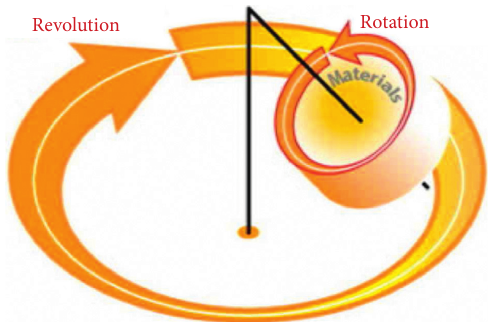
Figure 5: Rotation and revolution in a planetary